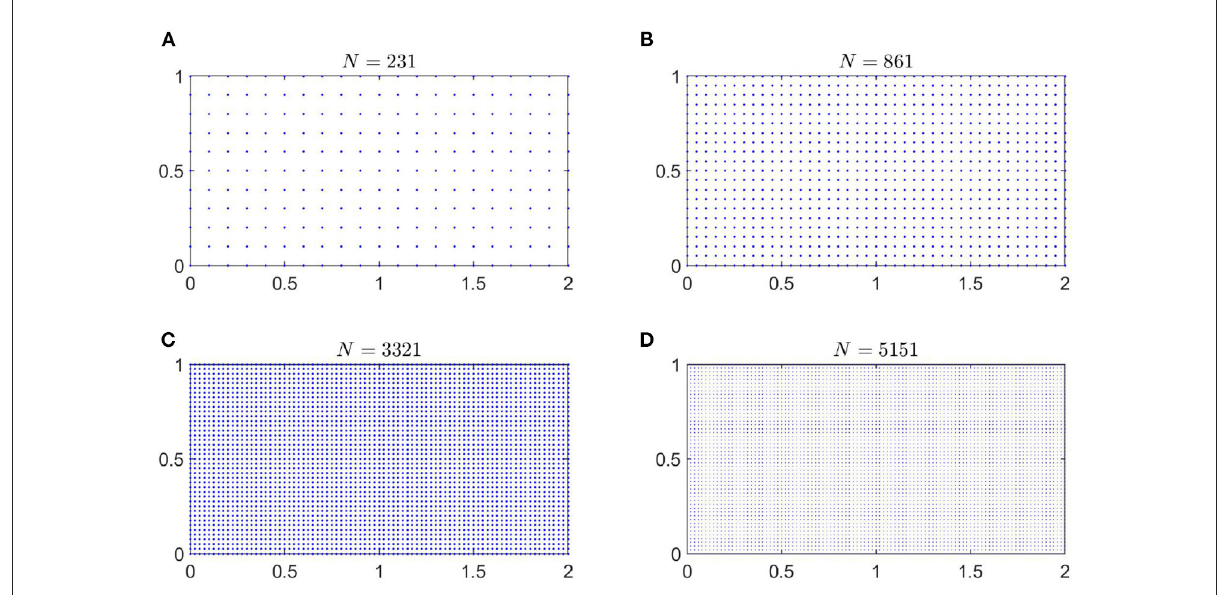
FIGURE4 Clouds of nodes for the Henry problem, using different number of total nodes. (A) N = 21 × 11 = 231, (B) N = 41 × 21 = 861, (C) N = 81 × 41 = 3,321, and (D) N = 101 × 51 = 5,151.